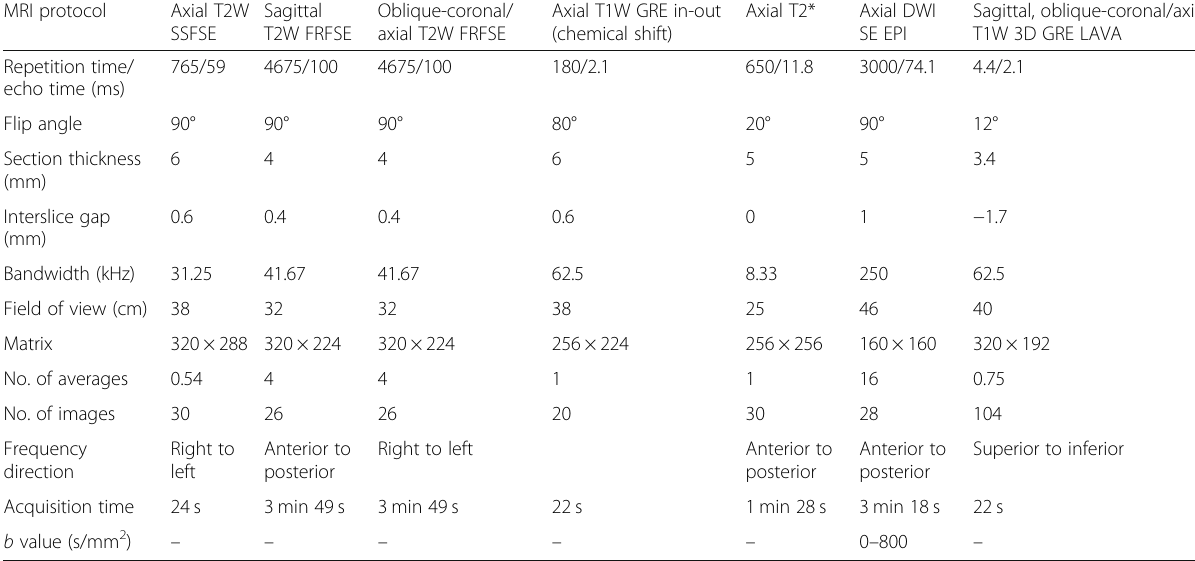
Table 1 State-of-the-art MRI protocol for comprehensive study of the female pelvis. Synoptic table summarizes the pulse sequence parameters. If not contraindicated, preliminary intramuscular or intravenous administration of an antispasmodic agent (e.g. N-butyl- scopolamine) may be performed. Axial T2-weighted SSFSE sequence is used as a second localiser. Sagittal T2-weighted FRFSE sequence is planned parallel to the long axis of the uterus, identified on the axial T2-weighted SSFSE sequence. Oblique-coronal and oblique-axial T2-weighted FRFSE sequences are planned parallel and perpendicular to the long axis of the uterus, respectively. Sagittal, oblique-coronal and oblique-axial T1-weighted 3D gradient-echo liver acquisition with volume acceleration (LAVA) sequences with fat suppression are obtained before and after intravenous administration of gadolinium-based contrast agent (0.1 mmol/kg, followed by 20 ml of saline solution, both at a 2 ml/s flow rate); in particular, the sagittal sequence is acquired at 60 and 120 s after contrast media administration. If needed, an additional urographic phase T1-weighted 3D gradient-echo LAVA sequence may be obtained in the sagittal, coronal and axial planes approximately 10 min after contrast administration. T2-weighted FRFSE, T2* and DW sequences are acquired with free-breathing technique, whereas T1-weighted 3D gradient-echo LAVA sequences are acquired in breath hold. T2* represents an optional sequence, not routinely